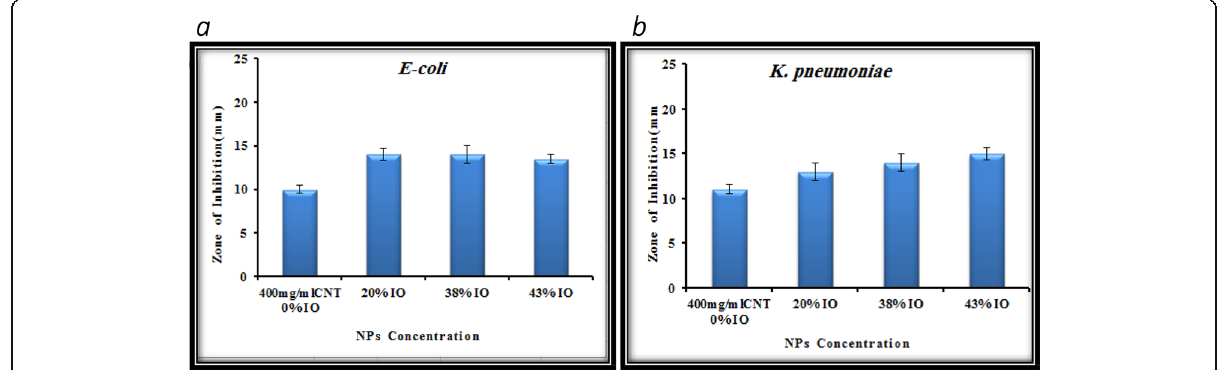
Fig. 4 Histograms of Anti-microbial growth activity stimulated by IO-MWCNTs. Composite against two types of bacteria gram negative: ( a ) E. coli , ( b ) K. pneumonia